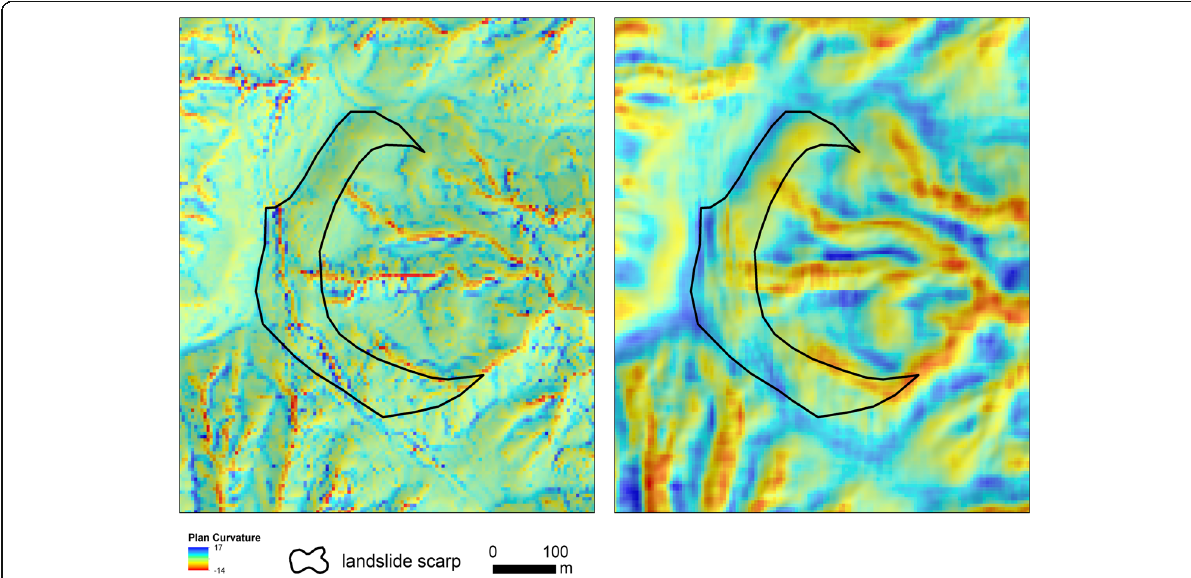
Fig. 10 Example of a scaled predictor in relation to a landslide scarp in the Shizuoka area. Left image: plan curvature at the default scale. Right image: plan curvature scaled in a 9 × 9 window. Note a north-south trench inside the landslide scarp on the left image is filtered out on the right